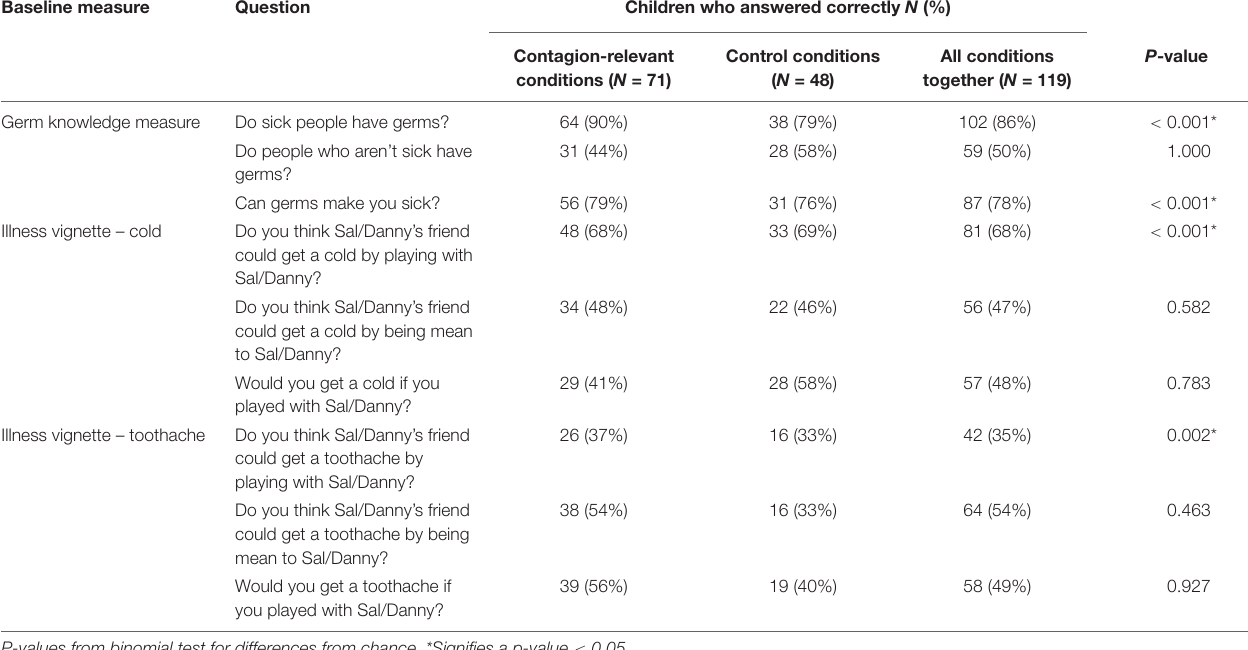
TABLE 1 | Children’s performance on closed-ended pre-test questions in the germ knowledge measure and illness vignettes across all conditions. Baseline measure